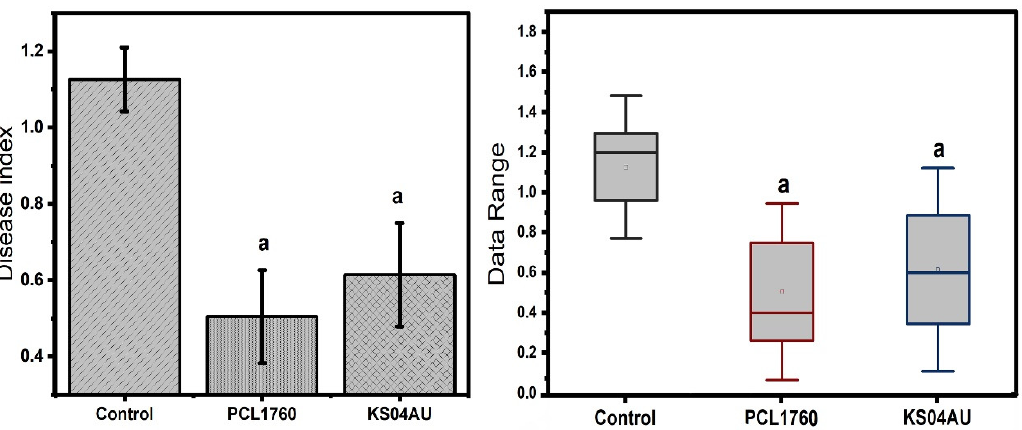
Figure 11. Biocontrol ability of B. velezensis KS04AU in suppression of tomato root rot disease diseases caused by Forl ZUM2407. Different letters above the bars indicate a statistically significant difference between groups at p < 0.05.